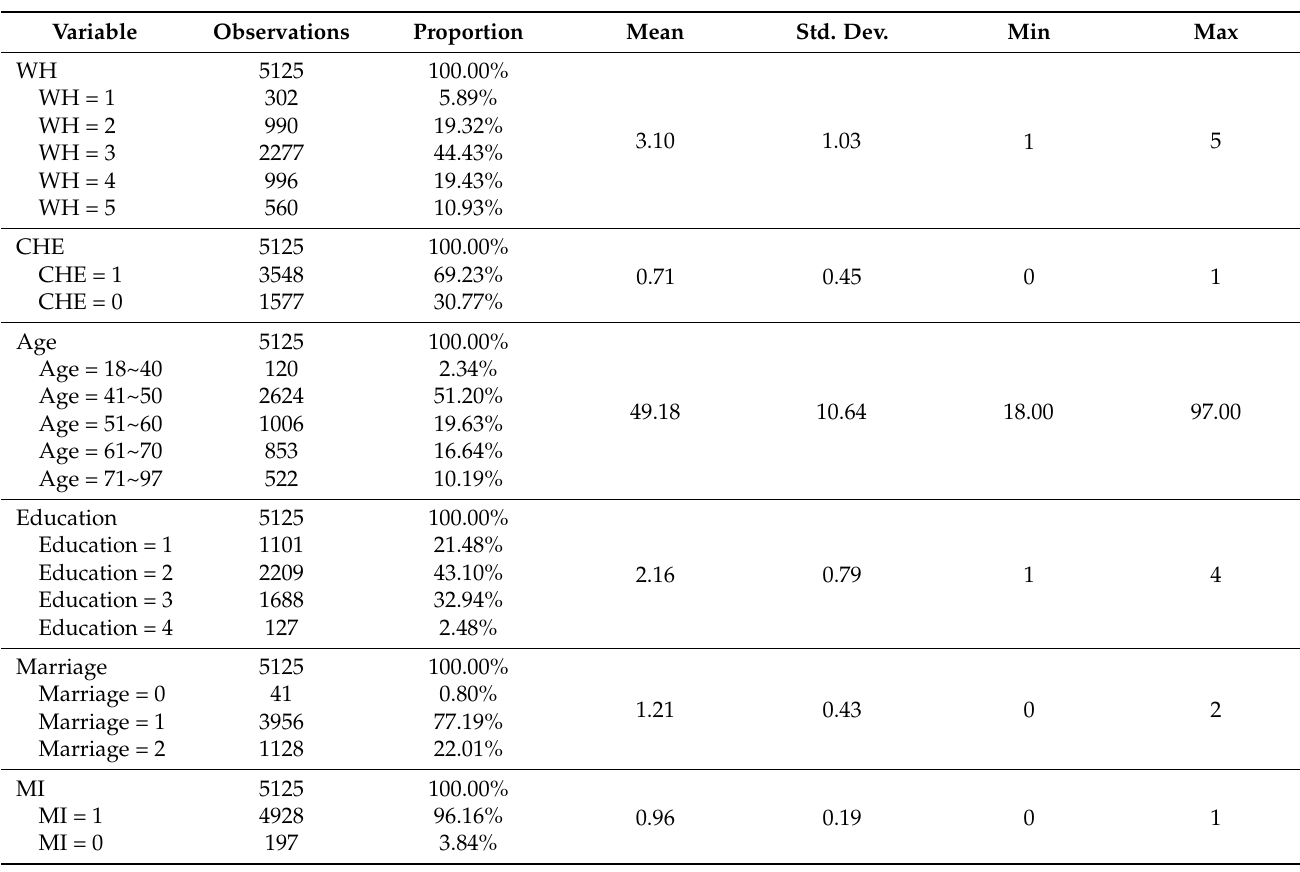
Table 2. Variable’s description